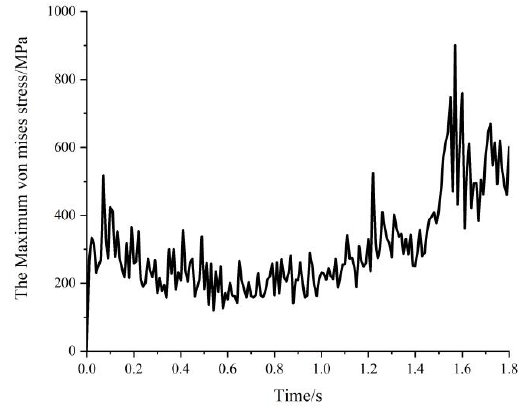
Figure 9. Maximum Von Mises stress–time curve of elastic teeth.